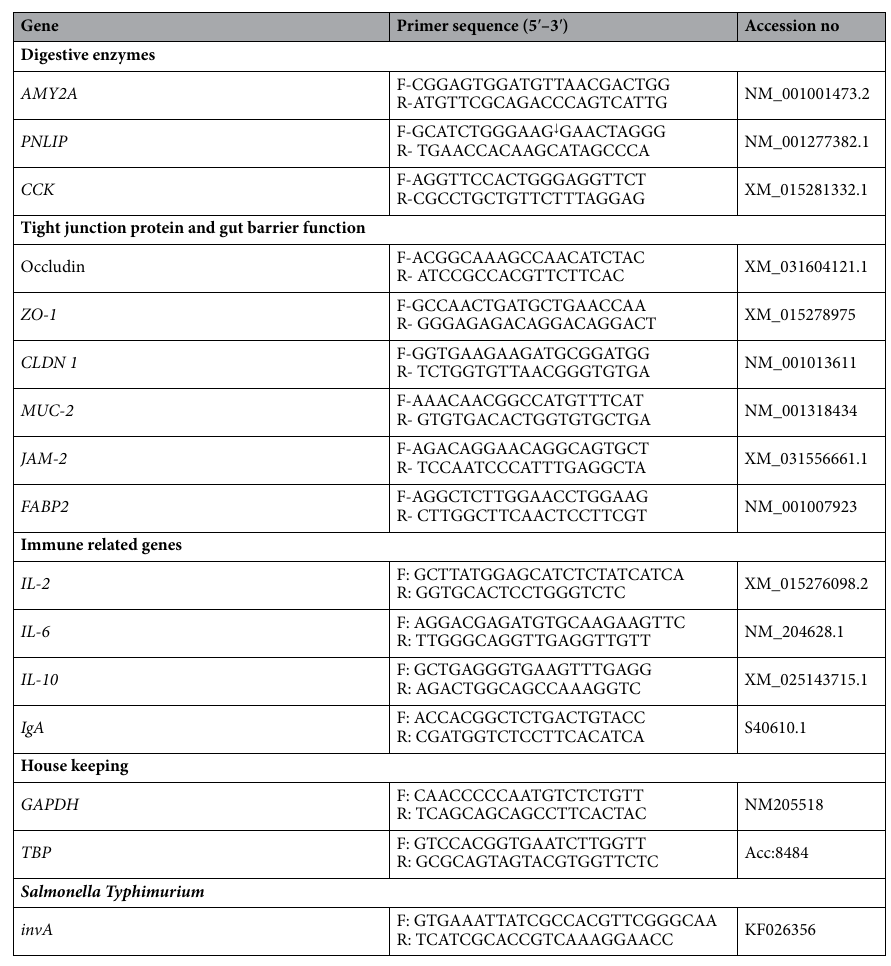
Table 3. Primer sequences used for gene expression analysis by RT-qPCR assay. AMY2A : pancreatic alpha 2A amylase; PNLIP : pancreatic lipase; CCK : cholecystokinin; ZO-1 : zonula occludens; CLDN 1: claudins-1; MUC- 2: Mucin-2; JAM-2 : junctional adhesion molecules-2; FABP2 : fatty acid binding proteins2; IL -2: interleukin-2; IL -6 : interleukin-6; IL-10 : interleukin-10; IgA : immunoglobulin A; GAPDH : glyceraldehyde-3-phosphate dehydrogenase; TBP : TATA-binding protein; invA : S . Typhimurium invasion protein A